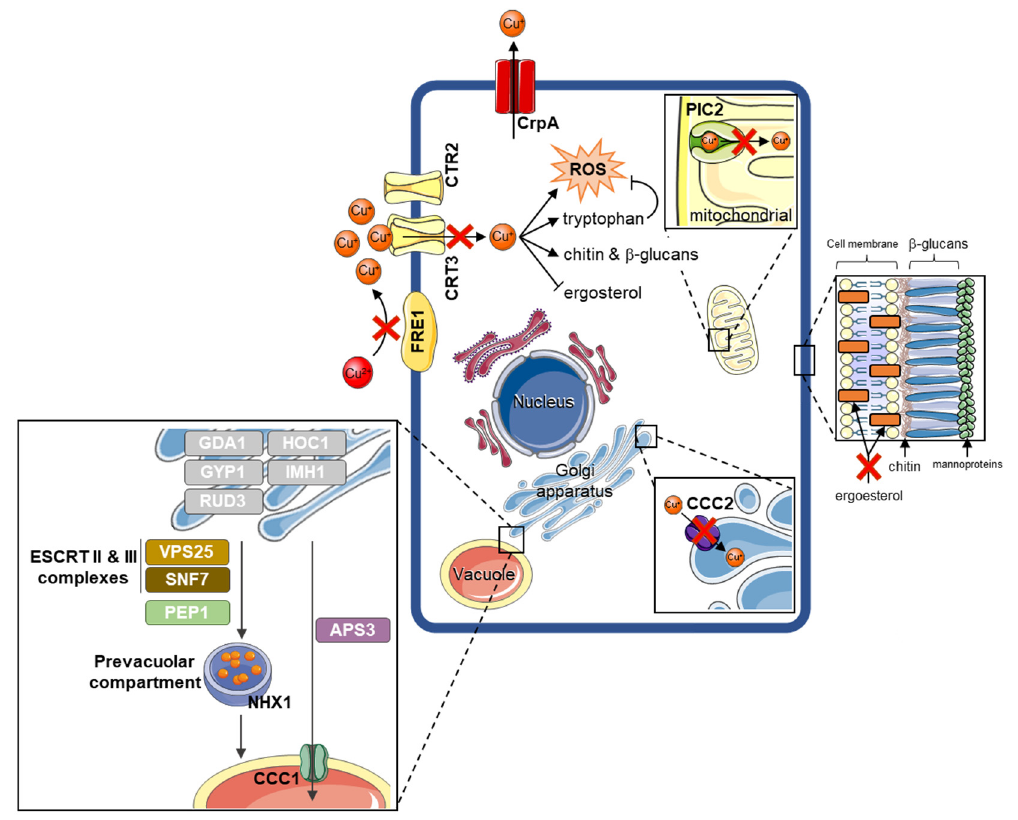
Figure 7. Schematic representation of mechanism involved in detoxification and the resistance to Cu-NPs treatments in F. kuroshium species. The membrane transporters and other proteins represented in the cell are named based on its yeast (Saccharomyces cerevisiae ) homologs.